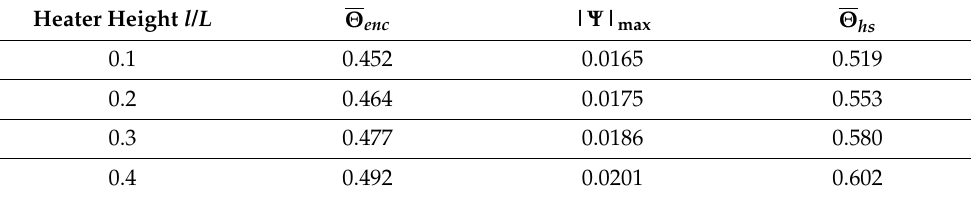
Table 3. Changes of integral characteristics with l / L at τ =